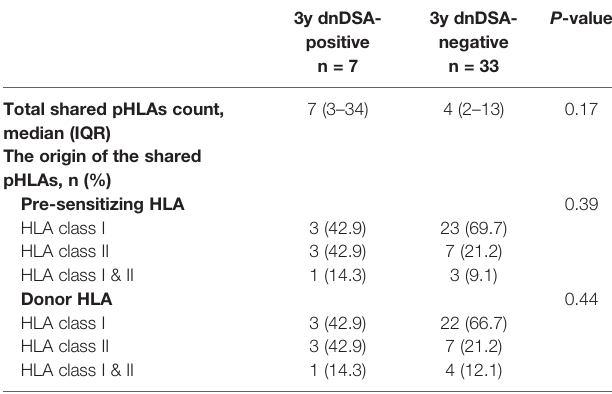
P 3y dnDSA- 3y dnDSA- positive negative